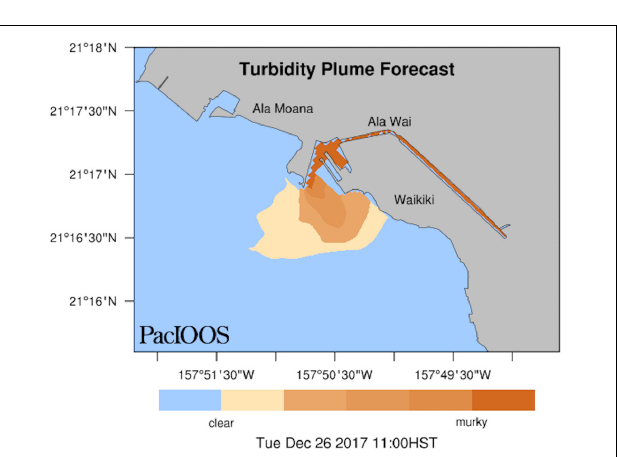
FIGURE 14 | An extreme high rainfall event in December 2017 caused a large turbidity plume off the coast of Waikîkî, Oahu, Hawai‘i. This is one image from a longer animation of the time period produced by PacIOOS. The movement and lifespan of the turbidity plume through time depends on oceanic and atmospheric conditions. Source: PacIOOS